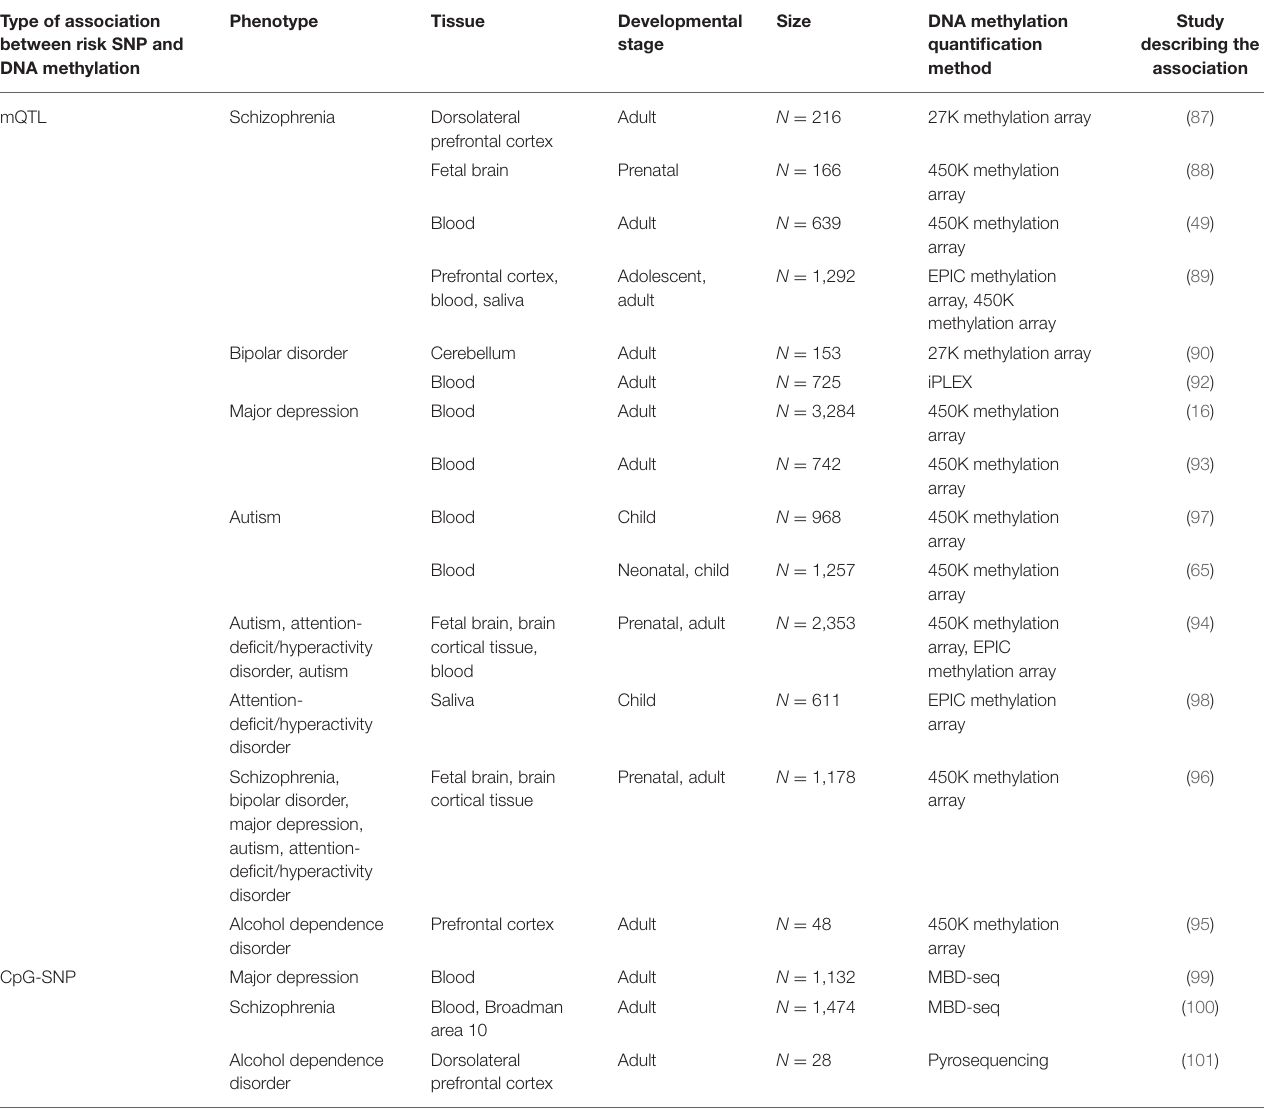
TABLE 1 | Overview of studies providing evidence on changes in DNA methylation associated with risk SNPs for common psychiatric disorders. Type of association between risk SNP